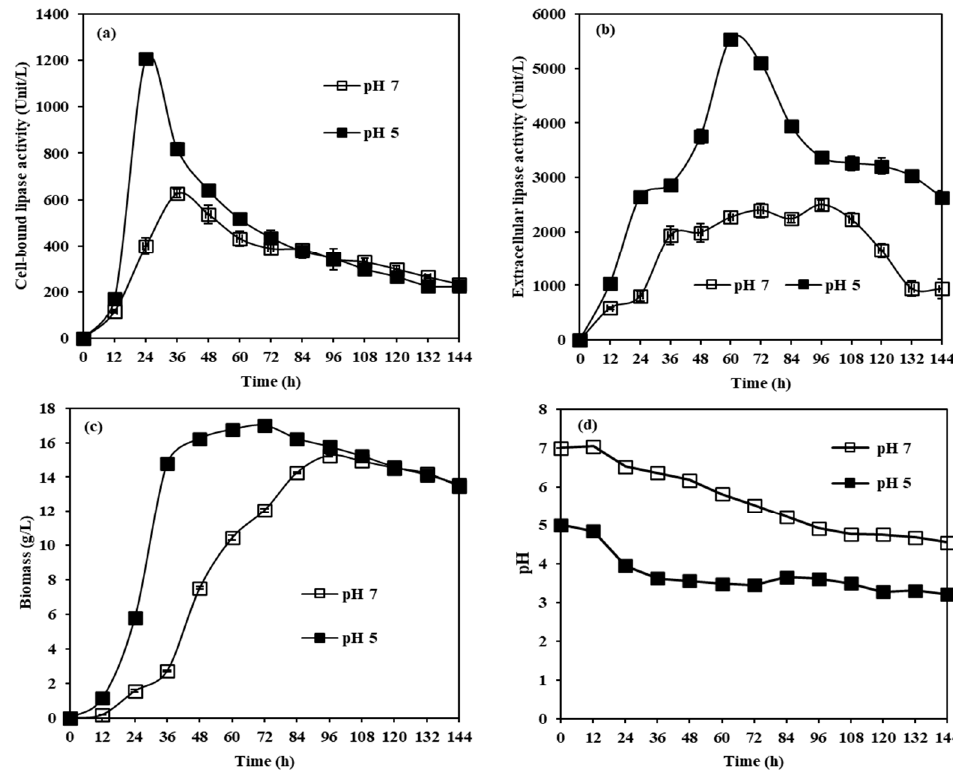
Figure 6. Effects of initial pH of culture medium on CBL ( a ), extracellular lipase ( b ), and biomass ( c ) production, and pH value of culture medium ( d ) from M. spicifer SPB2 in the IMY medium containing 2% soybean oil and 0.2% Gum Arabic, using an inoculum level of 1 × 10 7 cell/mL at 30 ± 2 °C under an aeration rate of 0.75 vvm and a stirring speed of 400 rpm.